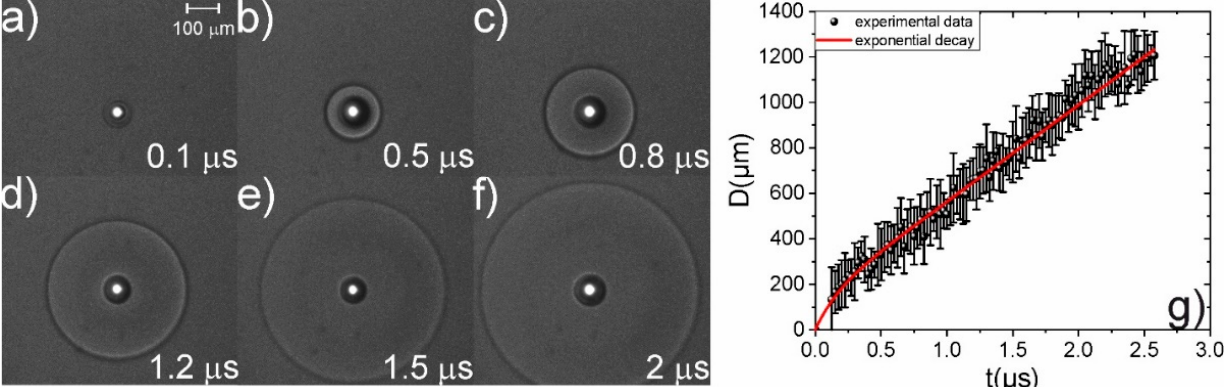
Figure 2. ( a – f ) Shadow photographs of the laser ‐ induced shock waves and the cavitation bubbles for various time delays between the pump and the probe pulses in scCO 2 , p = 75 bar, T = 40 ◦ C. ( g ) The evolution of the shock wave diameter in scCO 2 , p = 75 bar, T = 40 ◦ C, and the laser pulse energy is 400 µ J. The fitting is performed with the assumption that the shock wave velocity changes follow ‐ ing Equation (4).